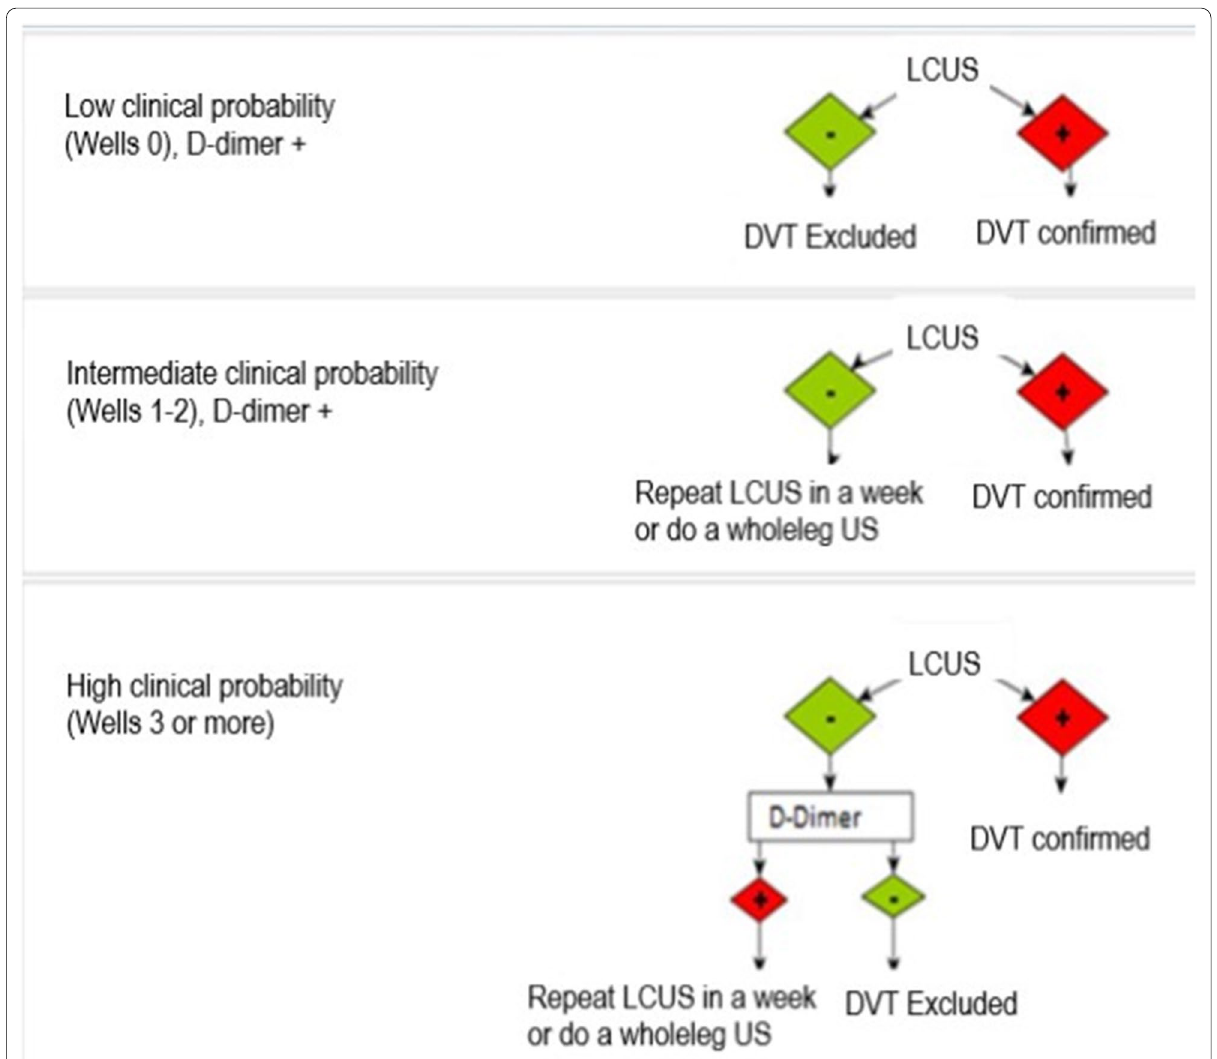
Fig. 1 Diagnostic model for the use of LCUS in suspected DVT. Modified from Central Finland Central Hospital recommendation in accordance with national Current Care Guidelines